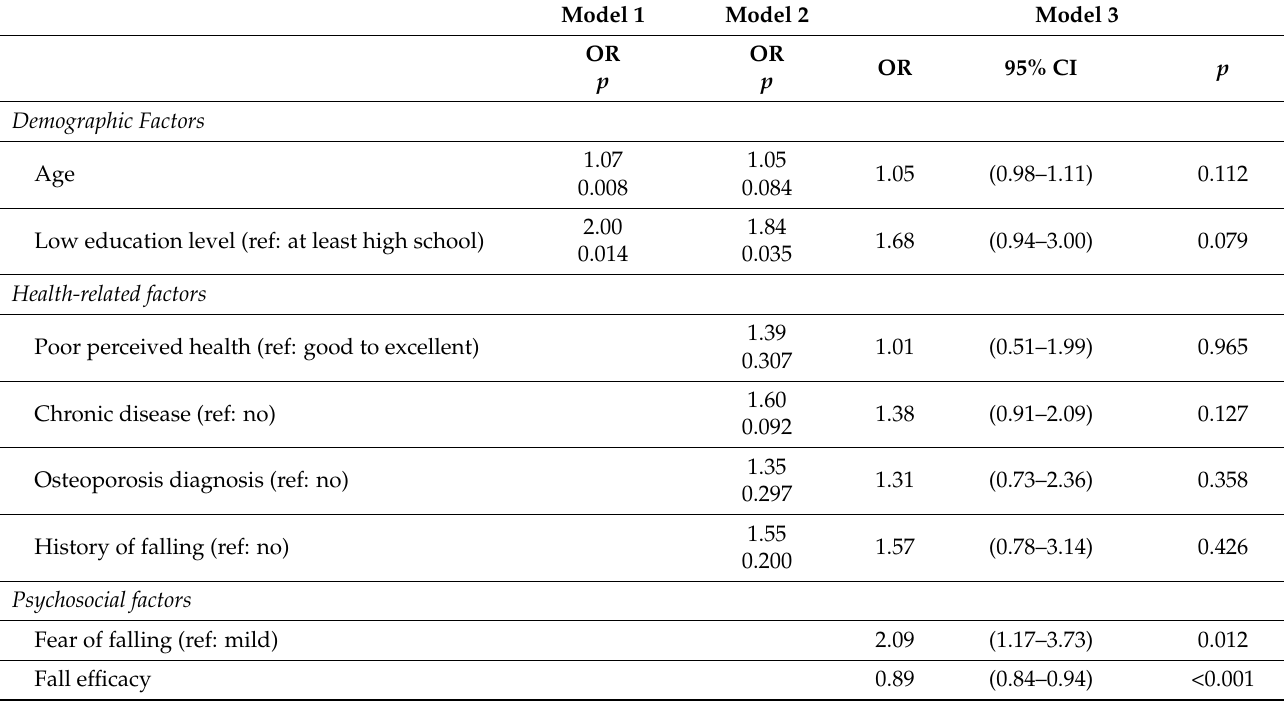
Table 4. Explanatory factors for fear-related activity avoidance ( N =